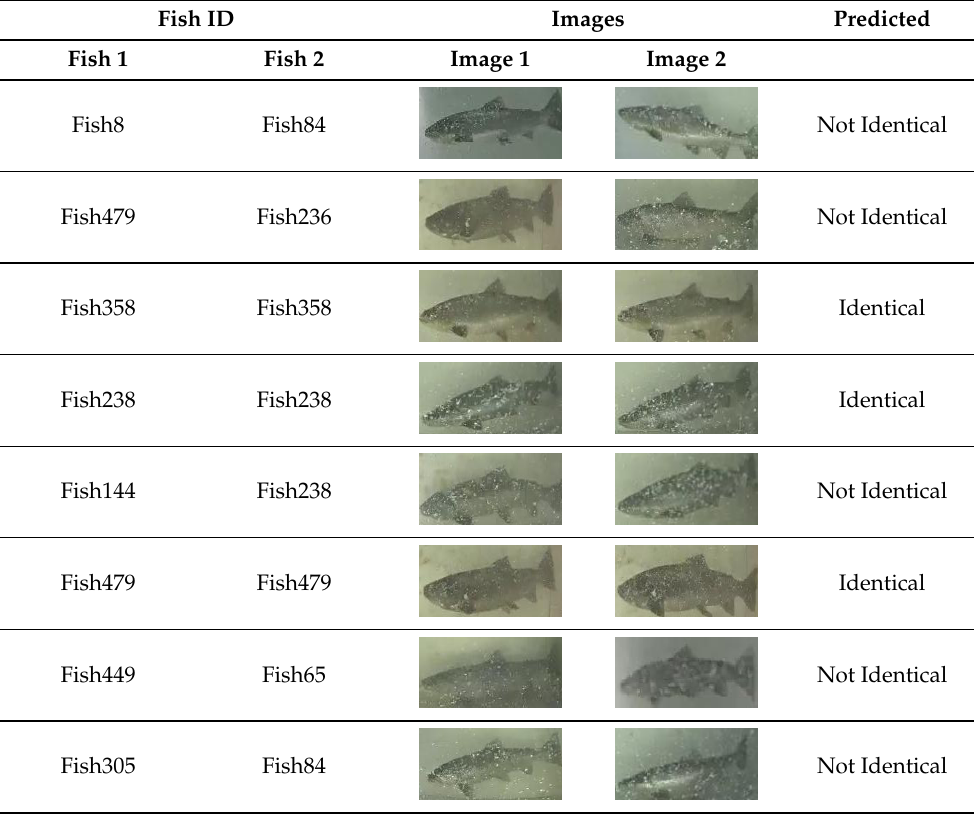
Table 4. Randomly chosen sample fish in NINA204 dataset that were correctly recognized. The iden- tification method was able to recognize difficult cases with significant variation in shape, turbidity, and